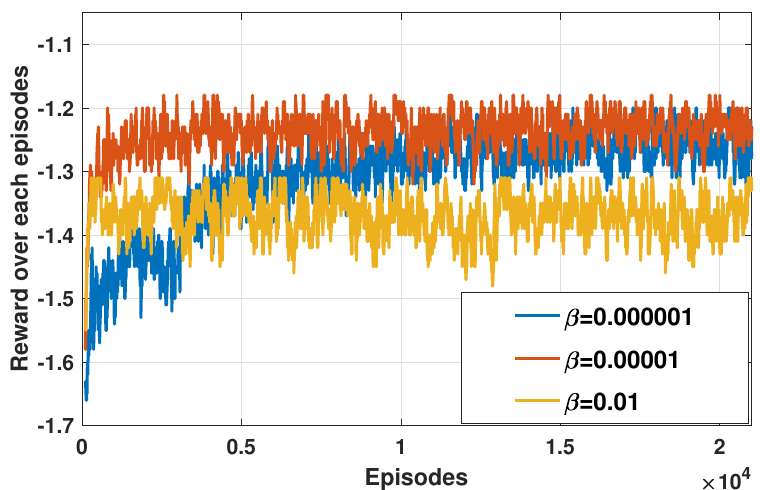
Figure 5. Effect of learning rate on the convergence performance of reward.